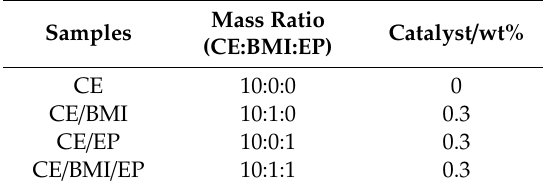
Table 1. Composition of pristine materials for preparing the CE–based copolymer composites.